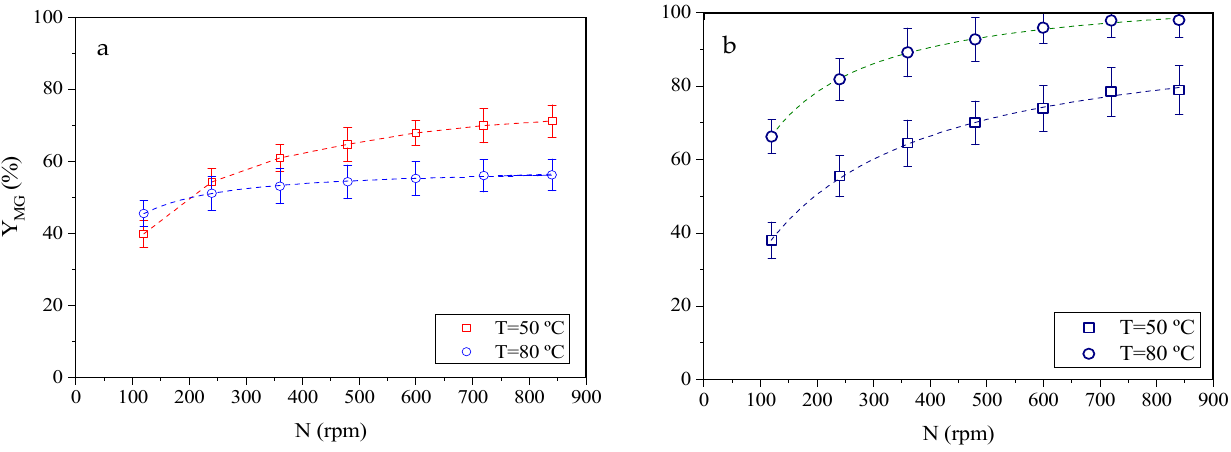
Figure 7. Influence of the stirring speed (mixing) on the yield to ibuprofen monoglyceride in a triphasic glycerol-toluene-N435 (L-L-S) system with no added water at zero time ( a ) and with 7.4% v / v added water (b) . Run operational conditions: T = 50 and 80 ◦ C, C I0 = 100 g · L − 1 , C E = 30 g · L − 1